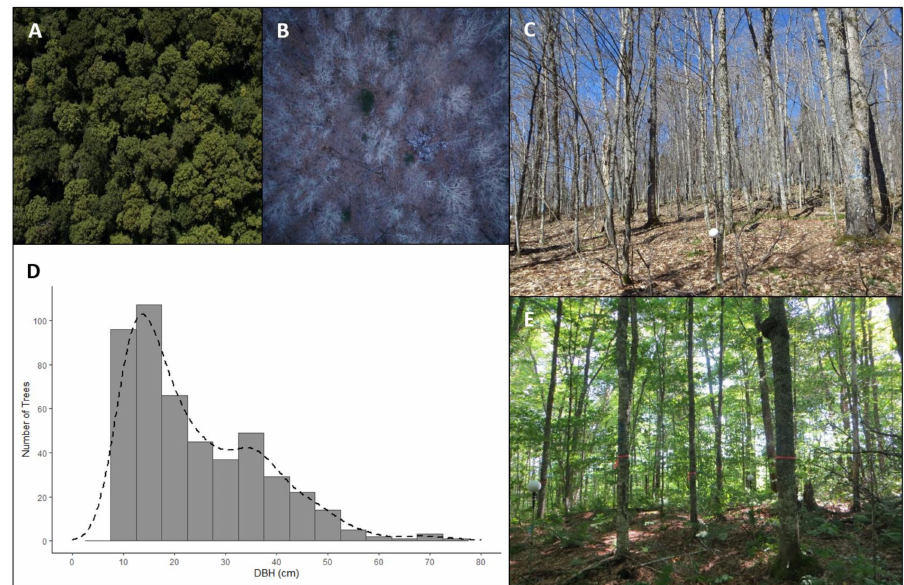
Figure 2. UAV photography that was taken above the study site during leaf-on ( A ) and leaf-off ( B ) acquisition, together with their corresponding in situ photographs (( C , E ), respectively); ( D ) DBH- distribution by 5 cm diameter class of the 477 trees that were measured in the 1 ha study